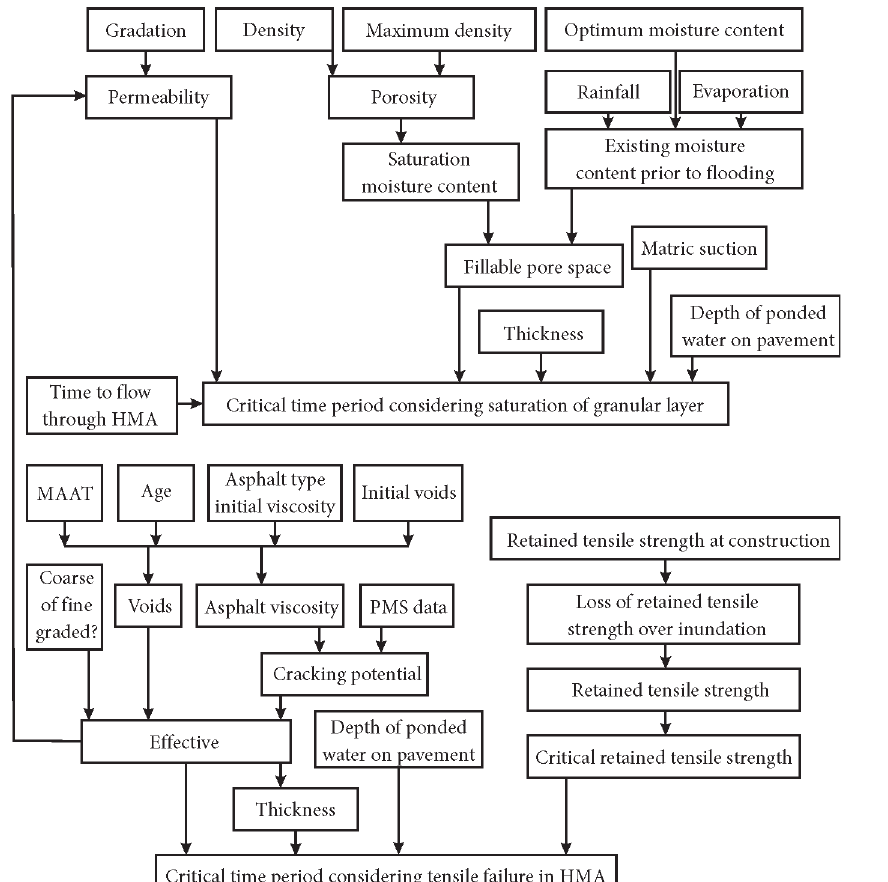
Fig. 1. Model for determination of critical flooding time Table 1. Factors affecting the time of saturation Parameter